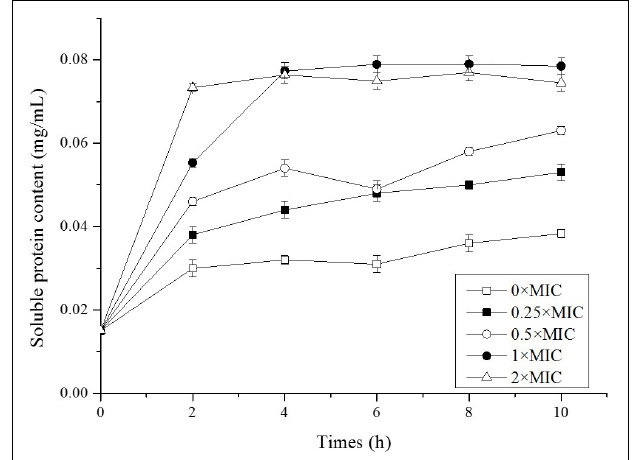
FIGURE 2 | The outer membrane (OM) permeability of Salmonella cells exposed to different doses of CGA.